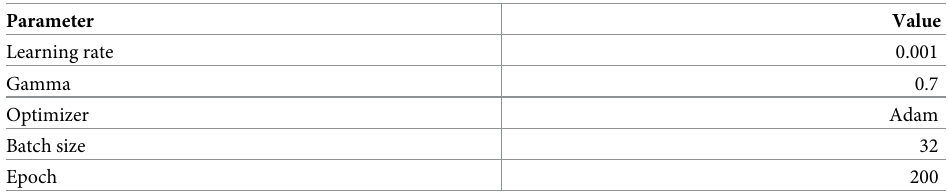
Table 2. Parameters setting of the proposed classification